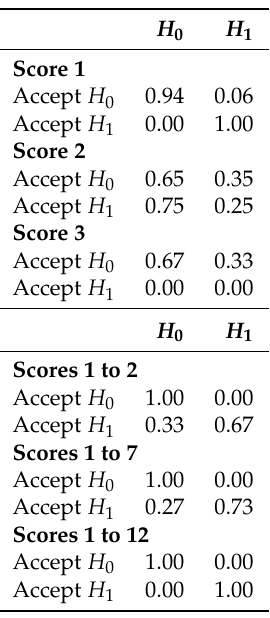
Table 9. True rate of false negatives and true rate of false positives of the test considering the first score, the second score, the third score (left); and scores 1 to 2 (jointly), scores 1 to 7 (jointly), and scores 1 to 12 (jointly) (right), when ν = 50 and α =